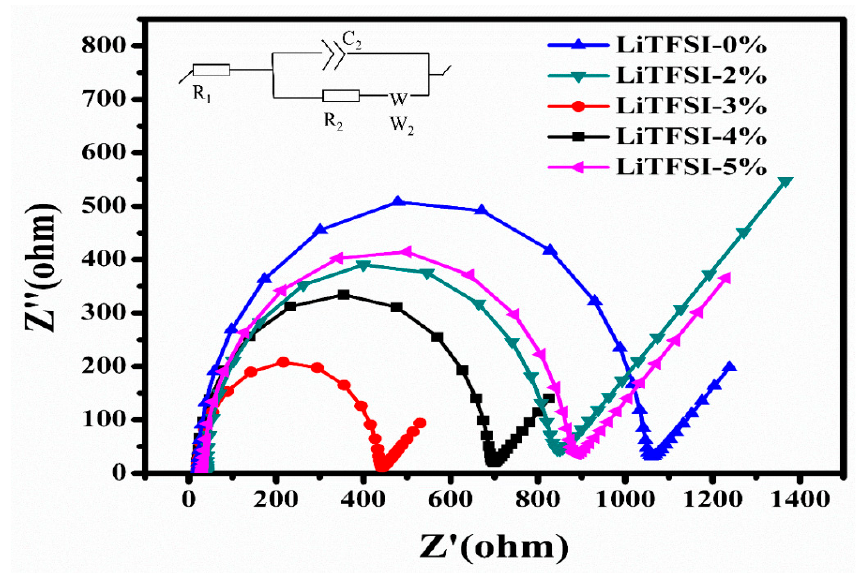
Figure 4. AC impedance spectra of the X% LiTFSI (X = 0, 2, 3, 4, and 5) +LiFePO 4 cath- ode//LATP/PVDF-HFP electrolyte membrane// Li cells at room